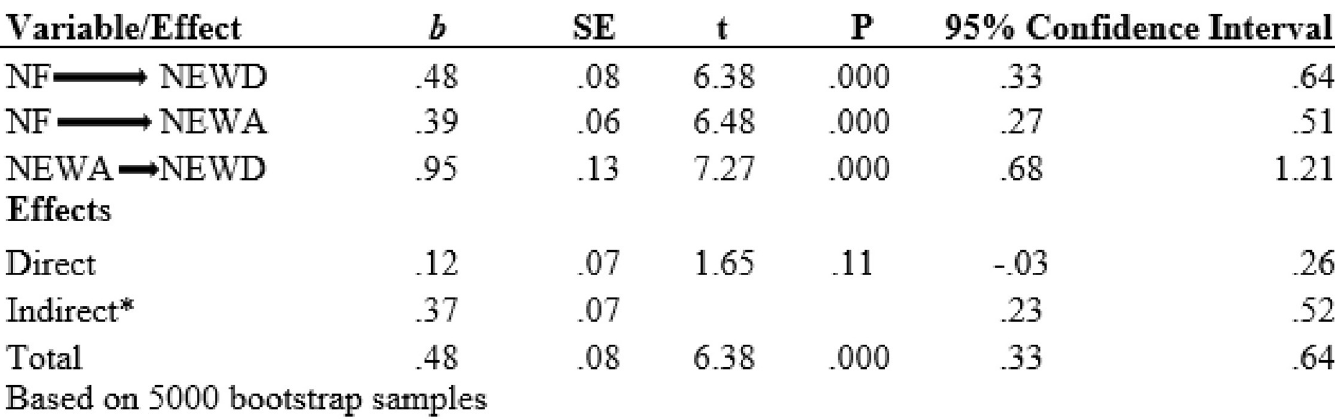
Fig 1. Mediation analysis.